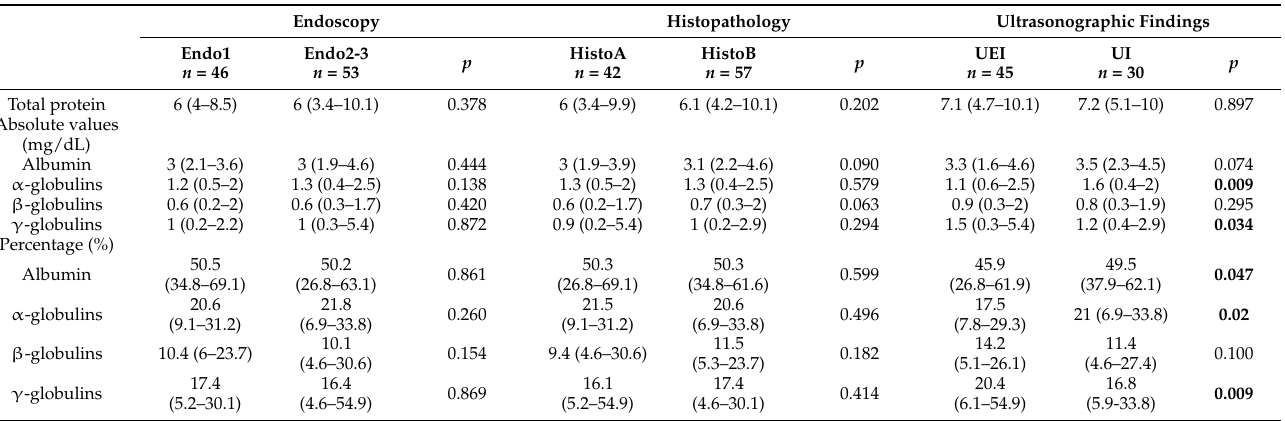
Table 1. Comparisons of SPE between groups based on endoscopy, histopathology and ultrasono- graphic